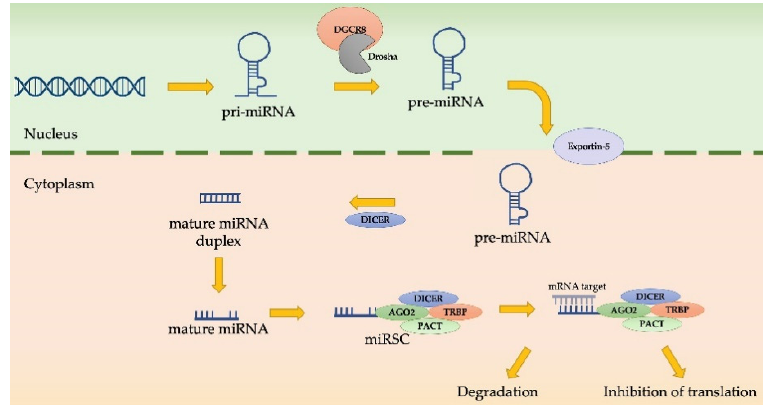
Figure 4. miRNA biogenesis and